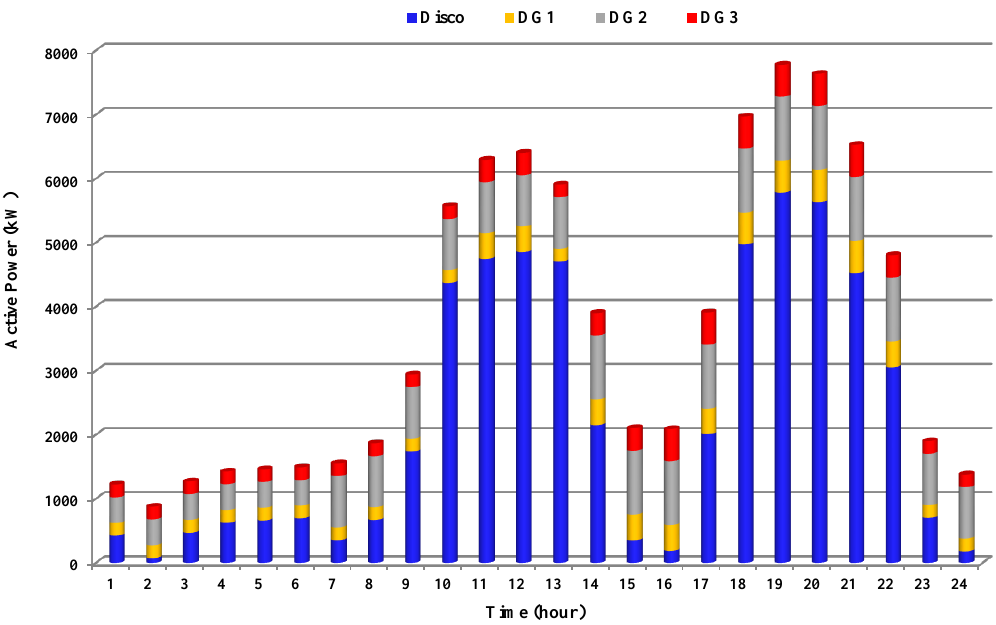
Figure 7. Initial active power dispatch obtained in the day-ahead energy-only market.